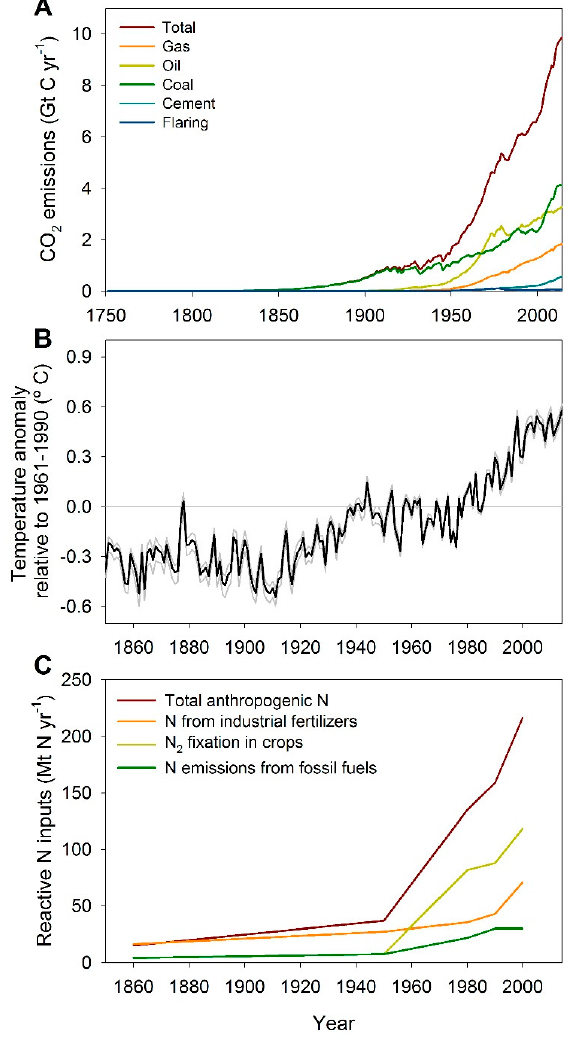
Figure 1. ( A ) Fossil fuel and cement CO 2 emissions by category, estimated by the Carbon Dioxide Information Analysis Center (CDIAC) based on UN energy statistics for fossil fuel combustion and US Geological Survey for cement production [30]. ( B ) Global average land-sea temperature anomaly relative to the 1961–1990 average temperature: grey lines represent upper and lower 95% confidence intervals [31]. ( C ) Anthropogenic reactive nitrogen inputs to the biosphere by sources [17].